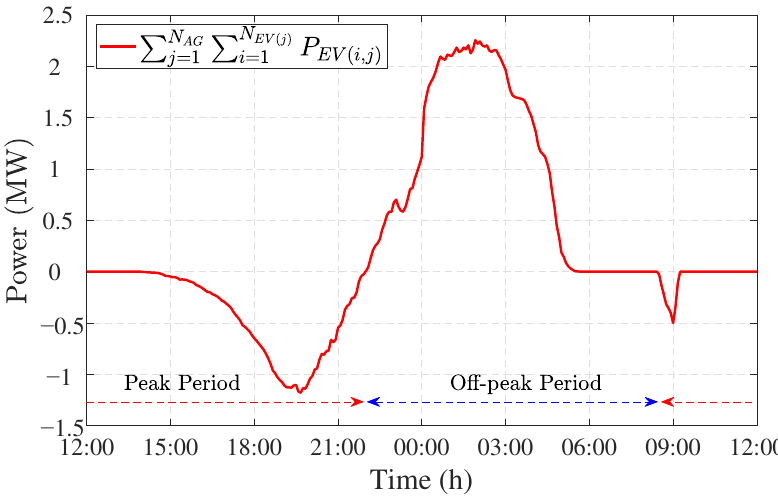
Figure 8. Net EV load on the